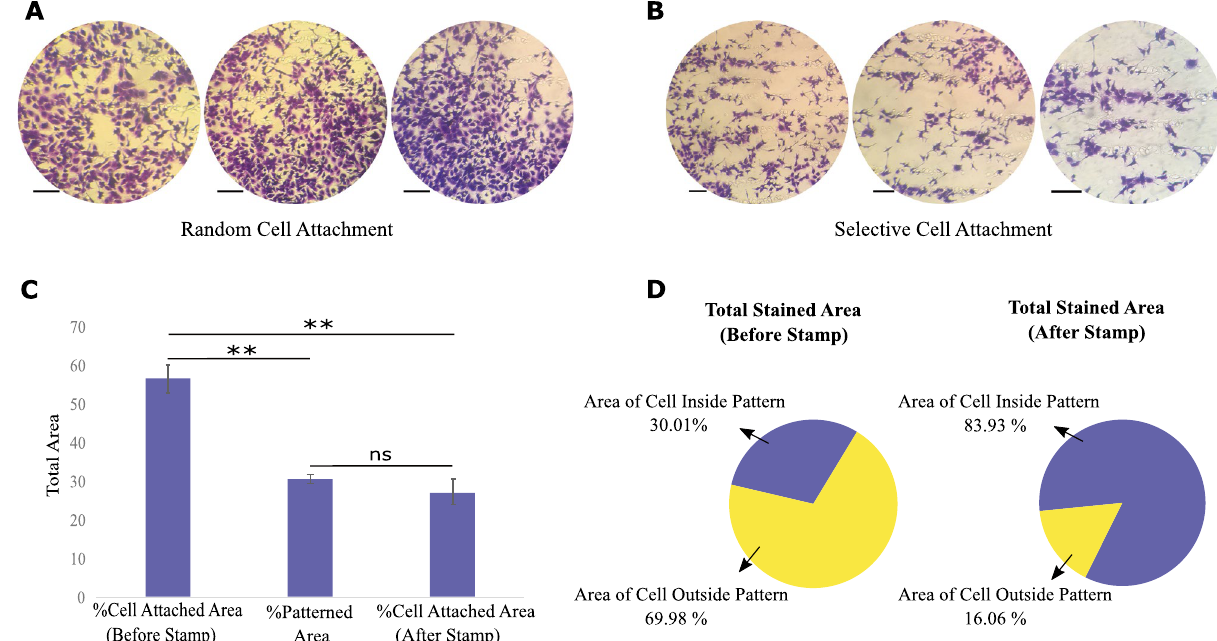
Figure 6. Crystal violet staining of ADSCs seeded on the collagen-immobilized PDMS substrate ( A ) before and ( B ) after using the stamp method (Scale bar = 80 μm). ( C ) The comparison between the total area of the attached cell before and after the stamp method with the total patterned area. ( D ) The ratio between the attached cells inside and outside the patterned regions before and after the stamp method. The measured area was measured by ImageJ software. The graph represents the mean ± SD. **p value of < 0.01 and (ns) indicates a statistically non- significant result between the two groups (N =